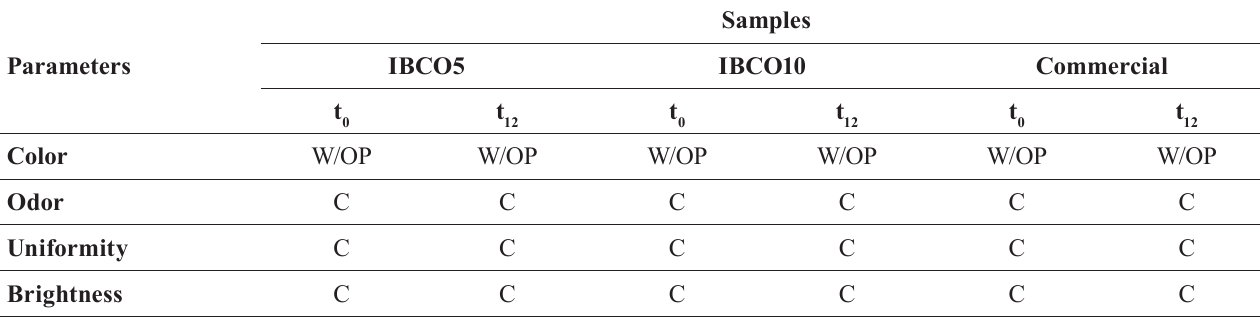
TABLE II - Preliminary stability studies of formulations after heat stress